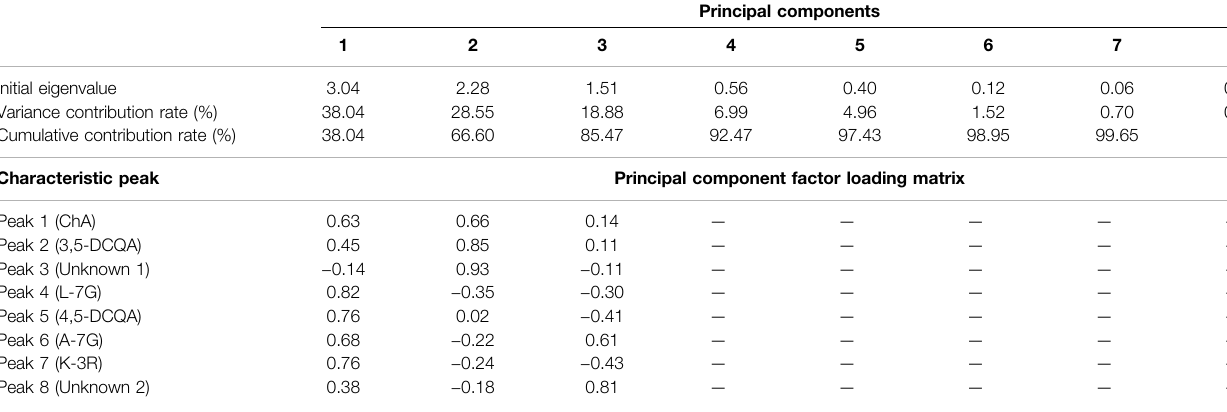
TABLE 3 | Principal component analysis and factor loading matrix of 30 fl ower head samples of